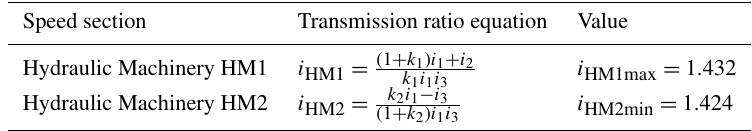
Table 2. Transmission ratio of hydraulic machinery HM1, HM2.